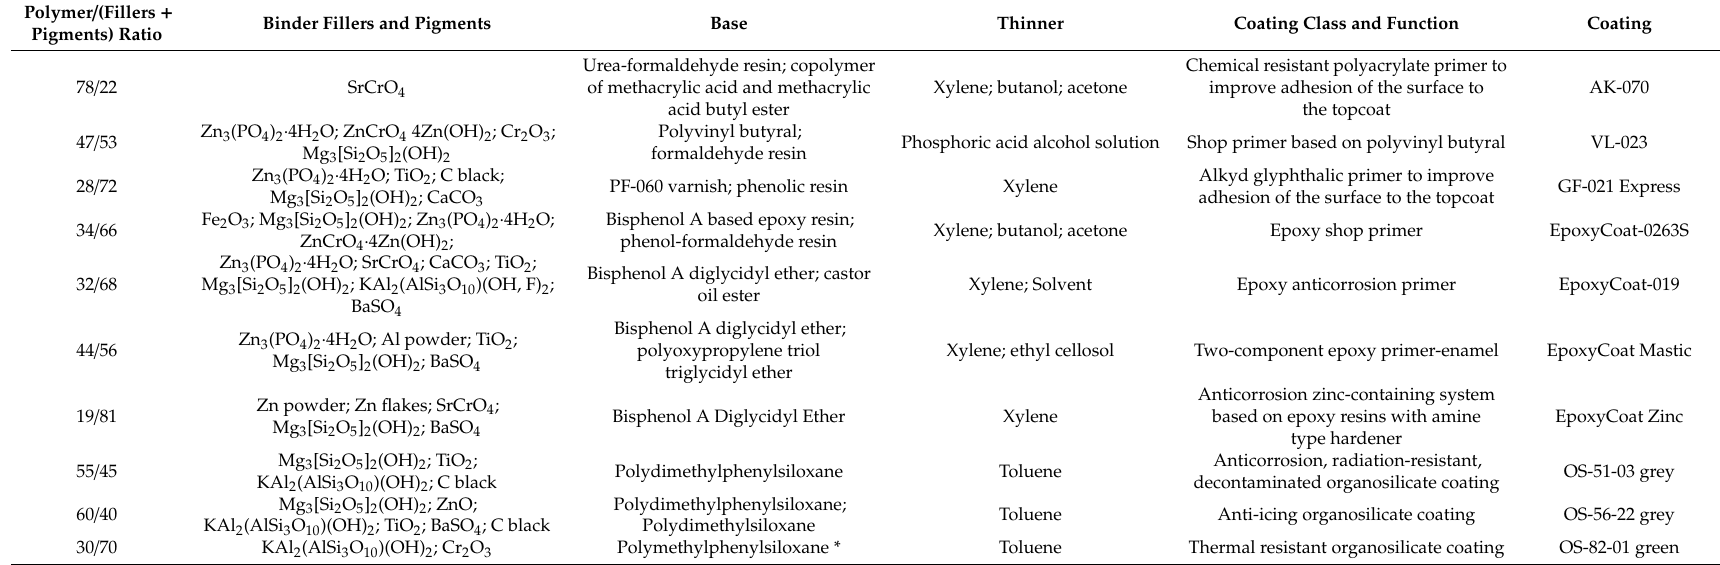
Table 2. Coatings compositions and functions used in the study.